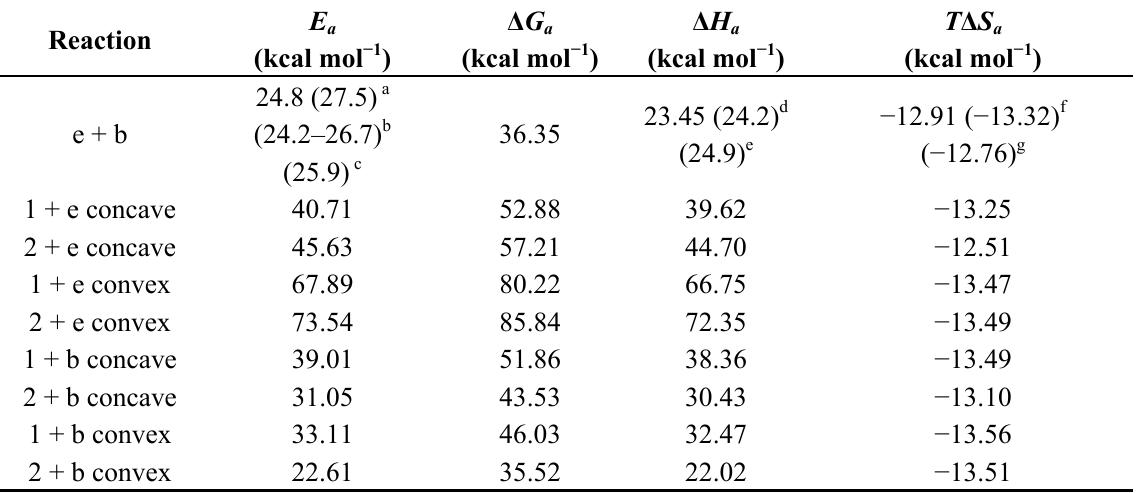
Table 4. Activation energy E , standard activation Gibbs energy Δ G , standard activation a a , and standard activation entropy T Δ S for Diels-Alder reactions of e and b with enthalpy Δ H a a fragments 1 and 2 . Data for the Diels-Alder reaction between e and b is given as